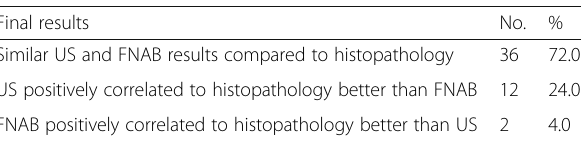
Table 7 Distribution of the studied cases according to final results ( n =